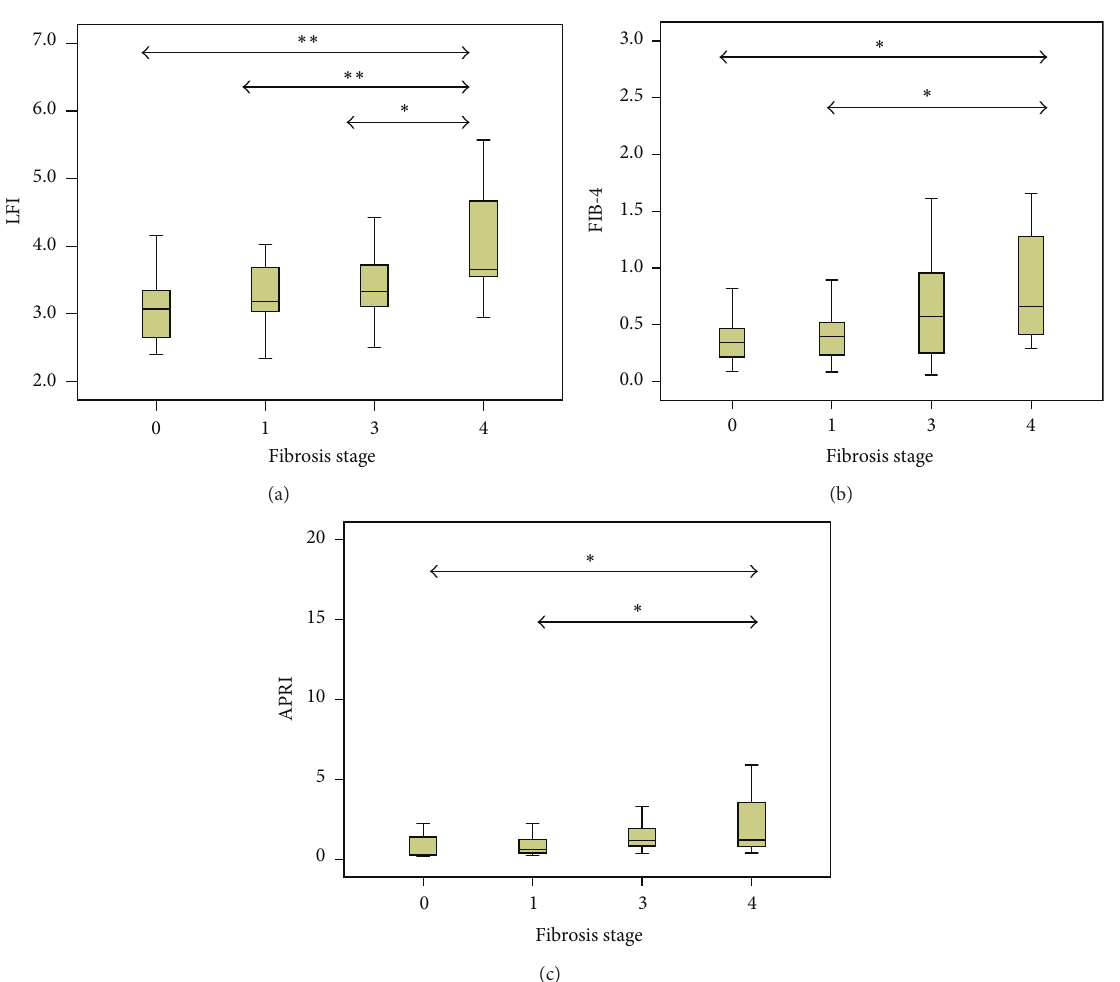
Figure 1: (a) Liver fibrosis index for each fibrosis stage. The increase of liver fibrosis index (LFI) with increasing fibrosis is shown and there is an evident separation between F0, F1, F3, and F4 groups. The lines through the middle of the boxes represent the means. The top and bottom of each box represents the 1st and 3rd quartiles. The length of the box represents the interquartile range within which 50% of the values were located ( ∗ 𝑃 < 0.05 , ∗∗ 𝑃 < 0.001 , comparing between each fibrosis stage). (b) FIB-4 index for each fibrosis stage. There were significant differences in F0 and F1 with F4 ( ∗ 𝑃 < 0.05 , comparing between each fibrosis stage). (c) Aspartate aminotransferase/platelet ratio index (APRI) for each fibrosis stage ( ∗ 𝑃 < 0.05 , comparing between each fibrosis stage). Table 2: Areas under receiver operating characteristic (ROC) curves of liver fibrosis index and several serological makers for predicting liver fibrosis stage. F ≥ F3 F =